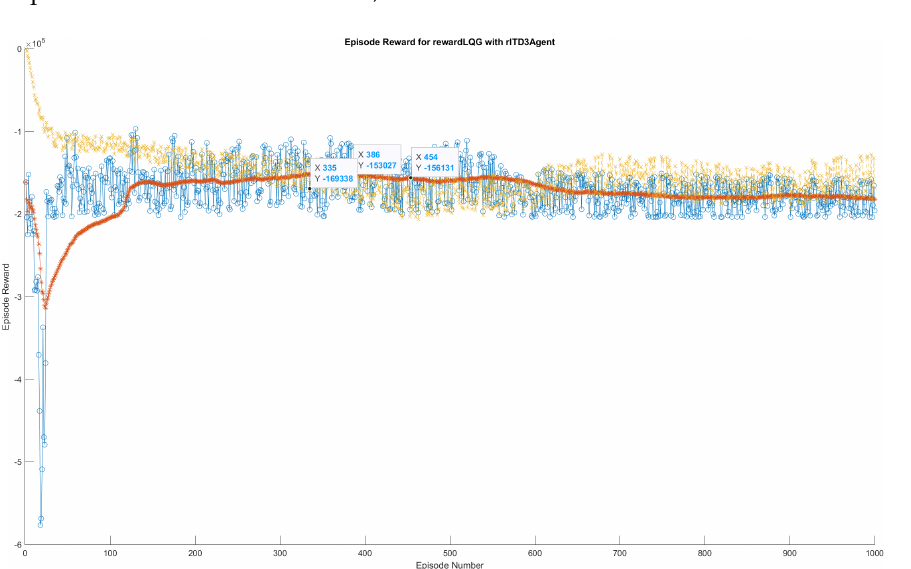
Figure 5. Learning of the TD3PG